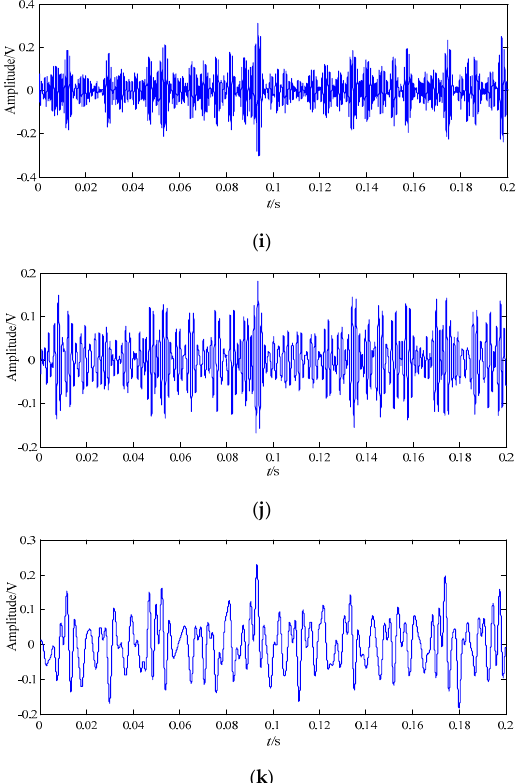
Figure 17. The best decomposition result of loose slipper fault signal based on IEWT in the time domain. ( a ) F 11 ; ( b ) F 10 ; ( c ) F 9 ; ( d ) F 8 ; ( e ) F 7 ; ( f ) F 6 ; ( g ) F 5 ; ( h ) F 4 ; ( i ) F 3 ; ( j ) F 2 ; ( k ) F 1 .